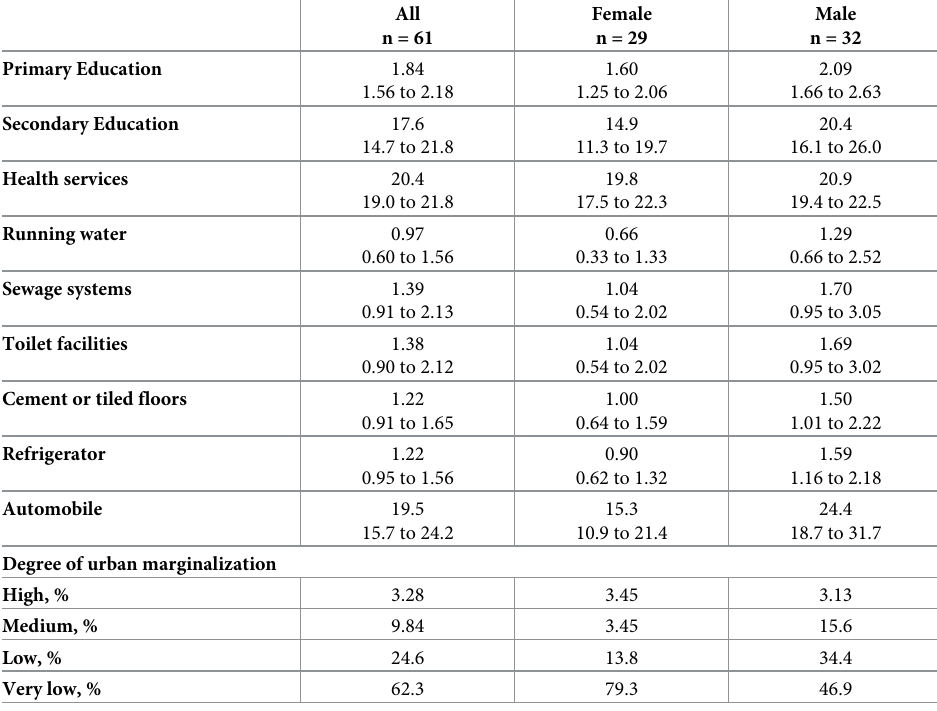
Table 1. Percent and 95% CI of individuals that do not have access to the following